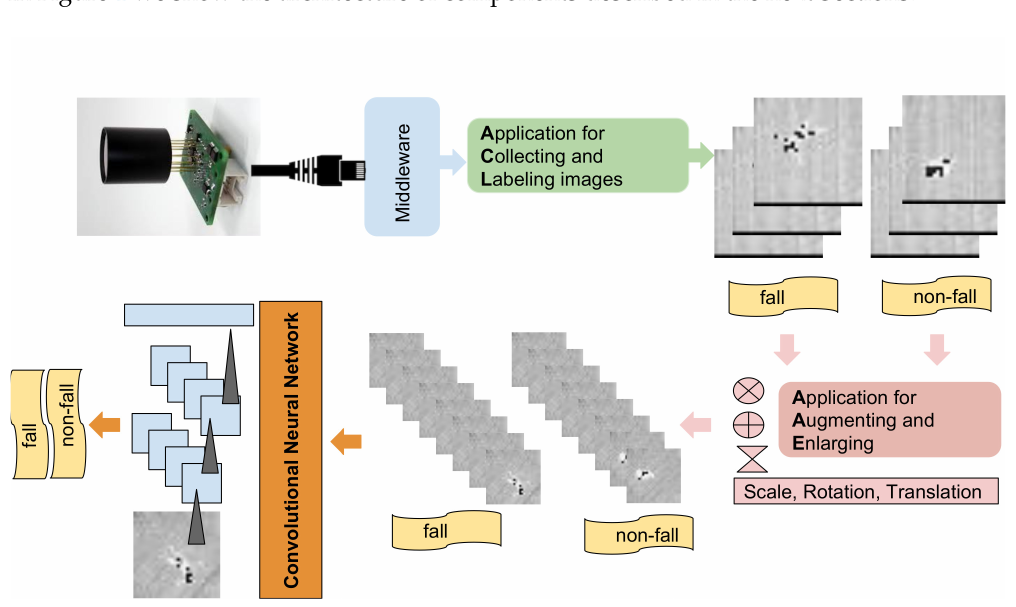
Figure 1. Architecture of components in